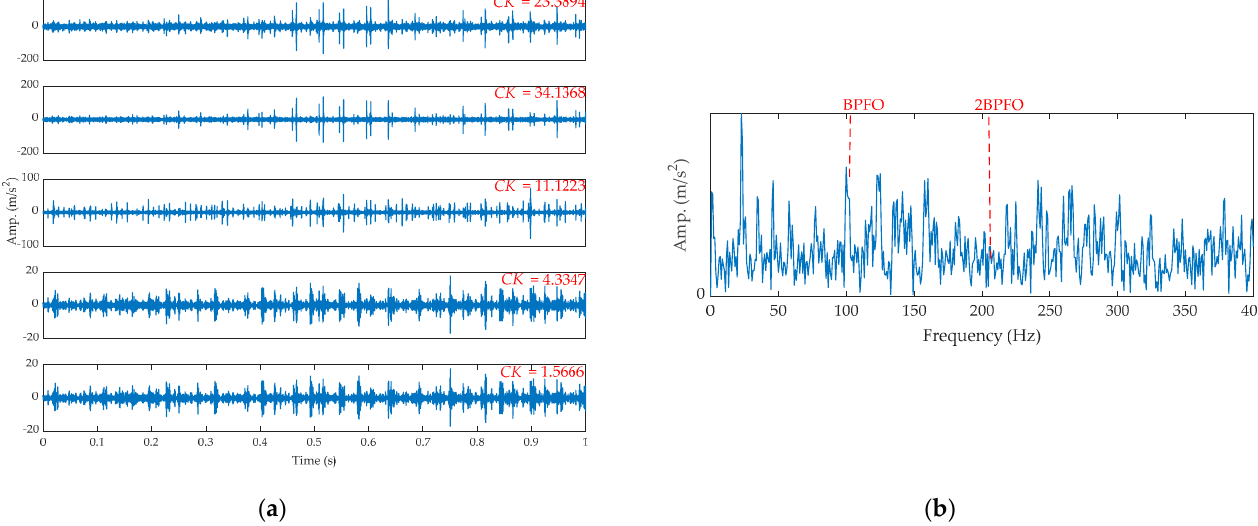
Figure 12. The results by EEMD for the outer fault signal: ( a ) intrinsic mode function (IMF) and ( b ) the SES of the second IMF.